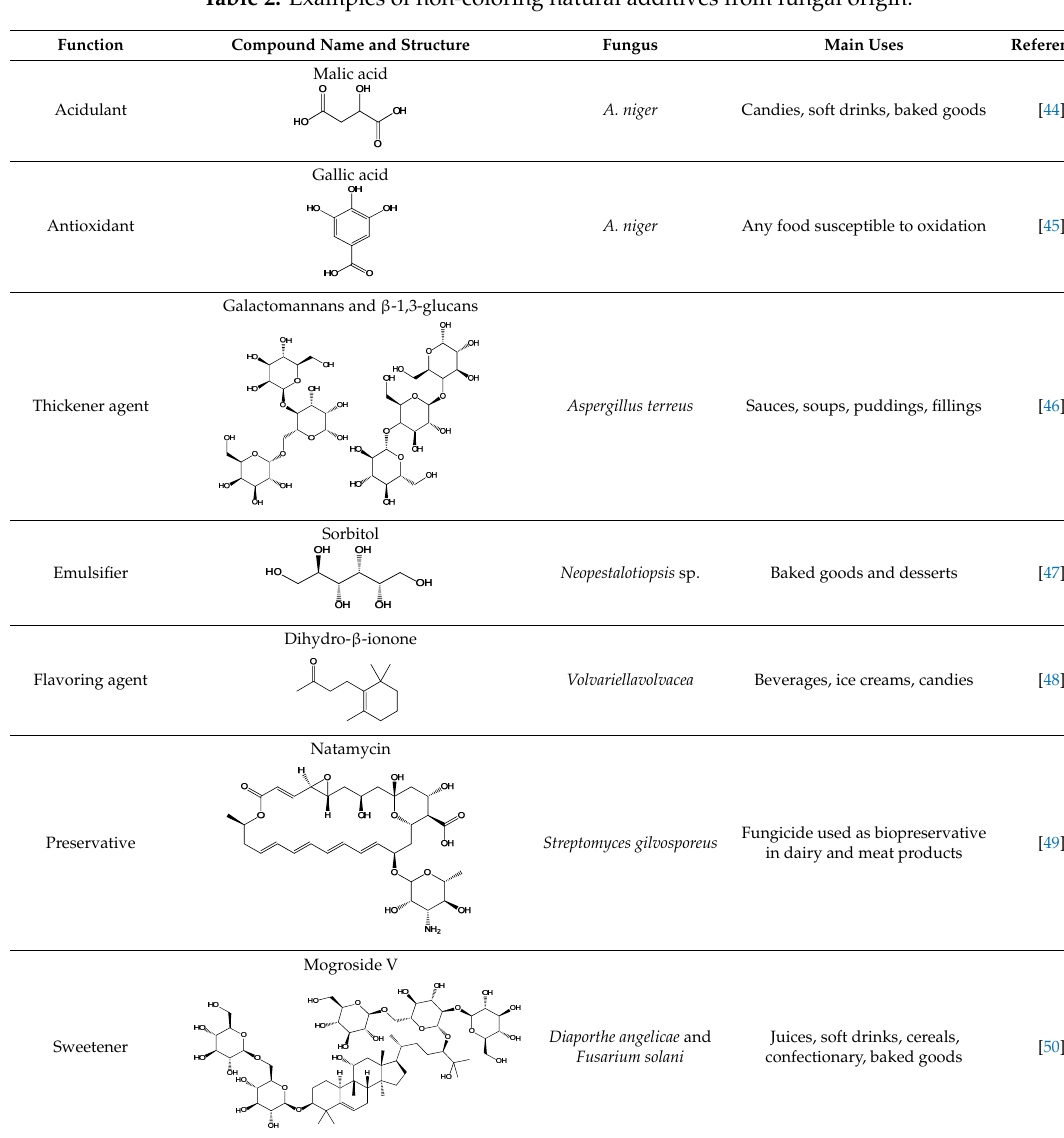
Table 2. Examples of non-coloring natural additives from fungal origin.